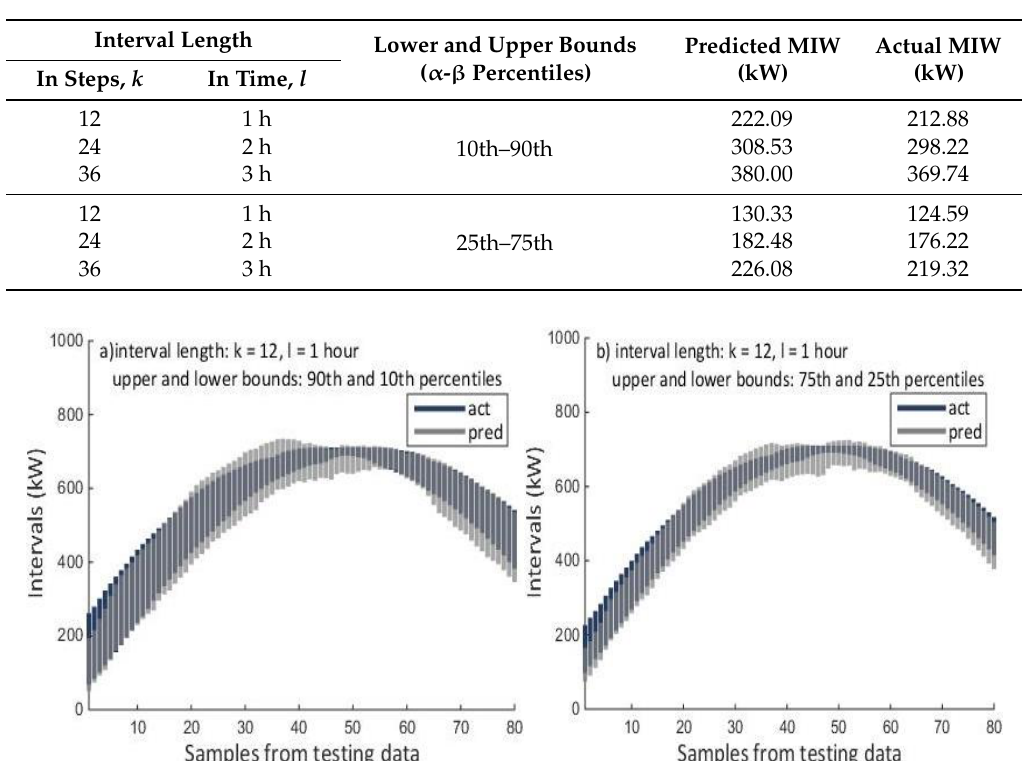
Figure 10. Intervals with lengths 1 h ( k = 12) for a subset of testing data.